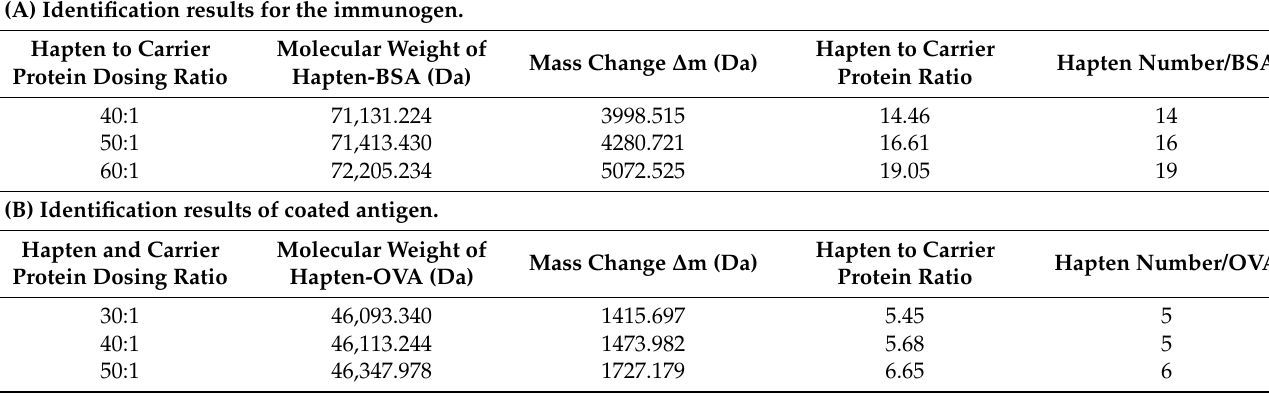
Table 3. Identification of the immunogen and coated antigen of